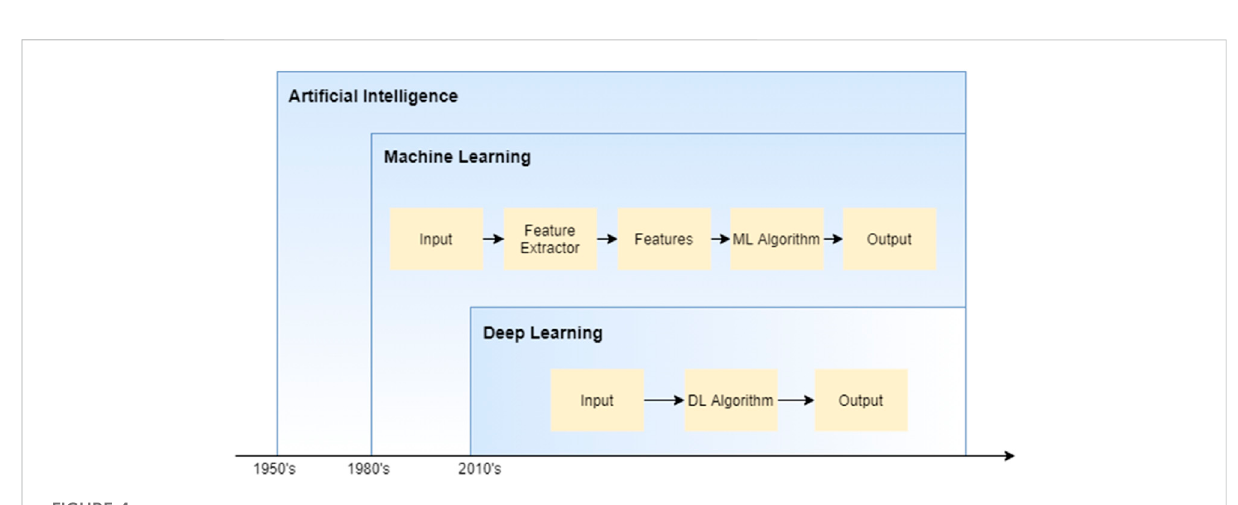
FIGURE 4 Arti fi cial intelligence and